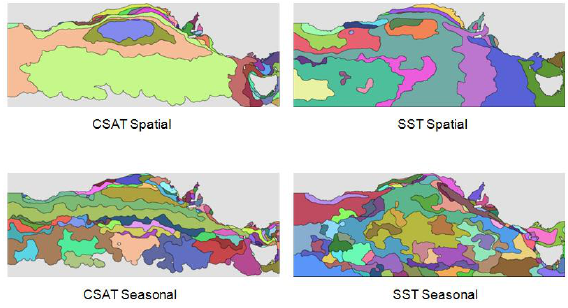
Figure 3: Southern Australian